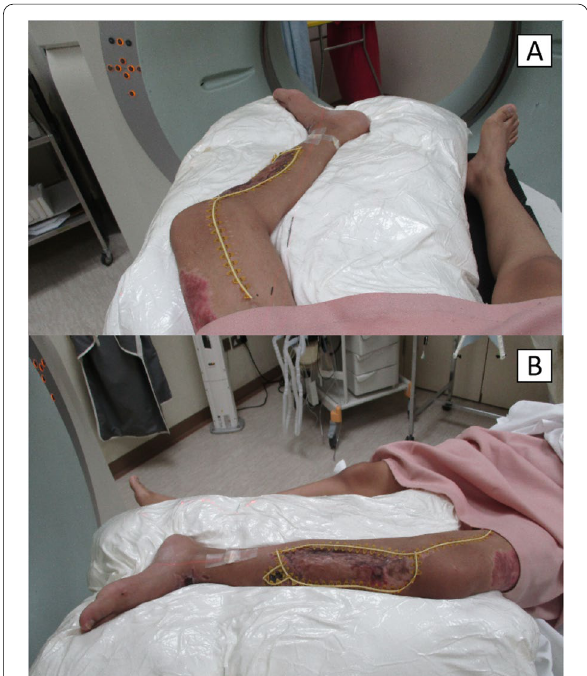
Vac‑Loc ™ immobilization device with landmarks on the patient and cushion ( A anterior view and B lateral